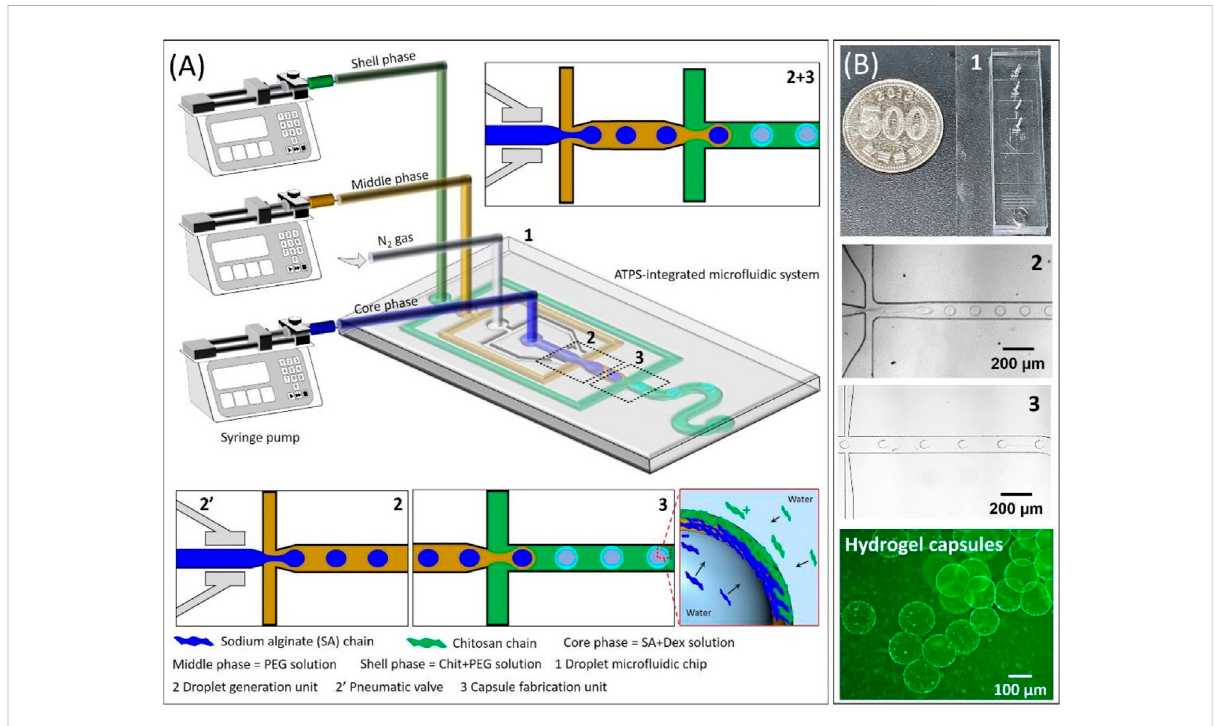
FIGURE 1 (A) Schematic illustration of oil-free all-aqueous-phase droplet micro fl uidic system platform to fabricate hydrogel capsules via interfacial complexation between oppositely charged polyelectrolytes, and (B) corresponding digital photograph and optical microscope images highlight different sections of the micro fl uidic chip and as-fabricated hydrogel